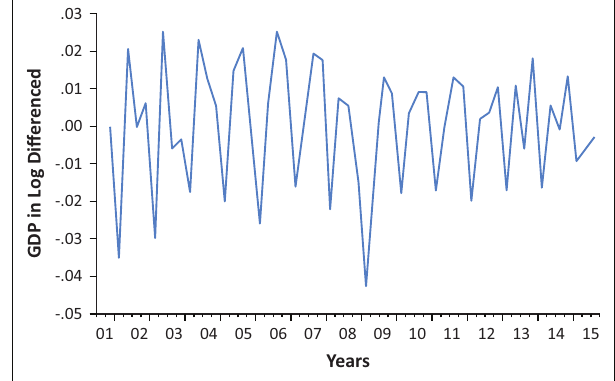
FIGURE 2: Provincial seasonal adjusted gross domestic product per skill adjusted labour supply (R billion, 2010 prices).